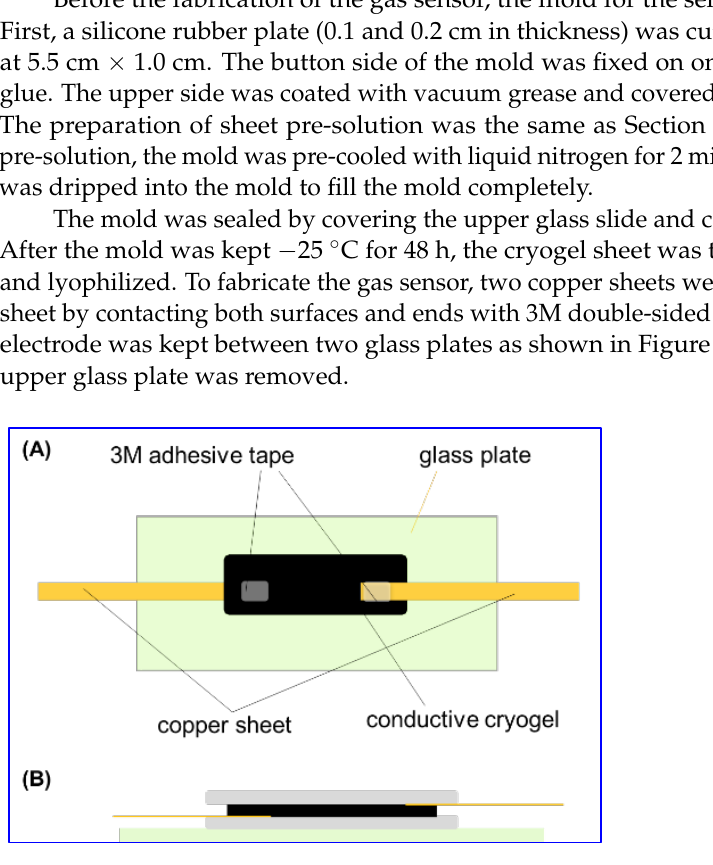
Figure 9. Fabrication of electrode for gas sensor with the overhead view ( A ) and cross-sectional view ( B ) of a cryogel electrode. ( B ) of a cryogel